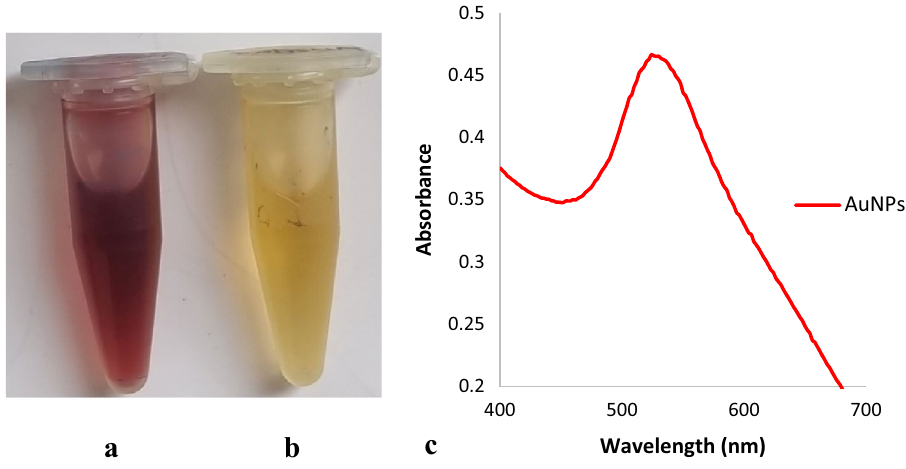
Figure 1. Formation of AuNPs in culture supernatant and their visible absorption spectrum. ( a ) Dispersion containing AuNPs, ( b ) control supernatant without AuNPs, ( c ) visible absorption spectrum of the produced AuNPs, showing maximum absorption peak at 530 nm. The formation of AuNPs can be easily observed by the color change from yellow to